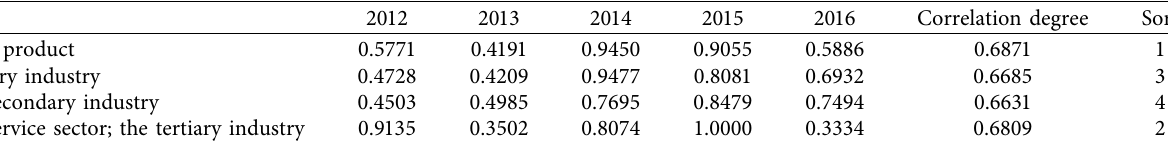
Table 4: The correlation coefficient, correlation degree, and ranking of convention and exhibition industry in Changsha.